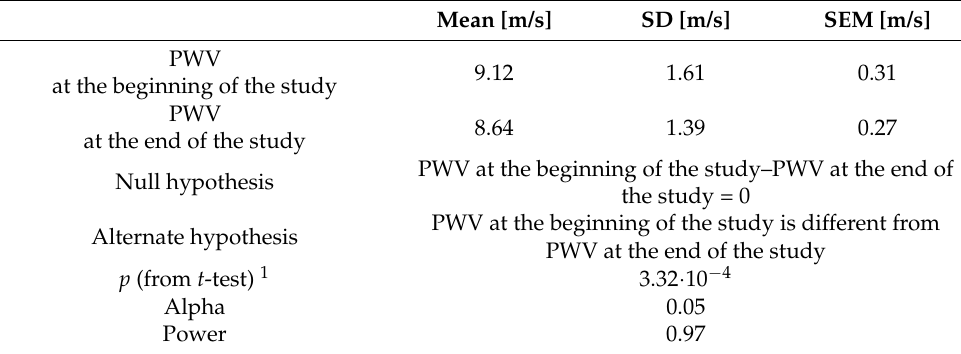
Figure 2. Pulse wave velocity (PWV) versus age of each subject at the beginning of the study (red squares) and at the end of the study (blue squares). Table 4. The results of the paired-sample t -test for the mean values of PWV from Figure 2.